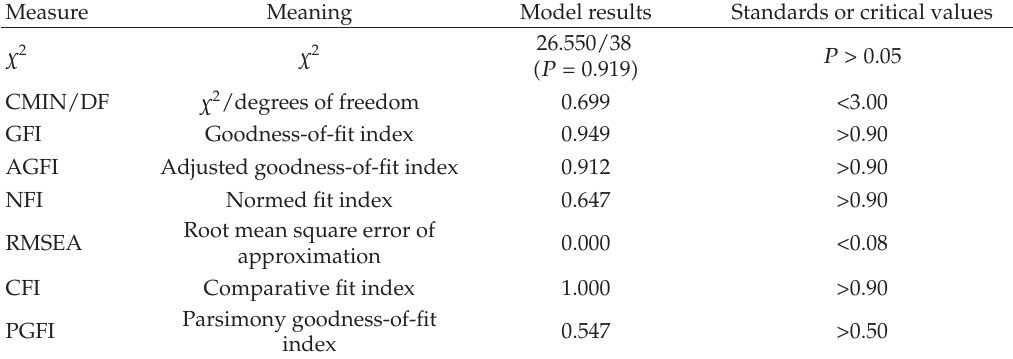
Table 2: Goodness-of-fit